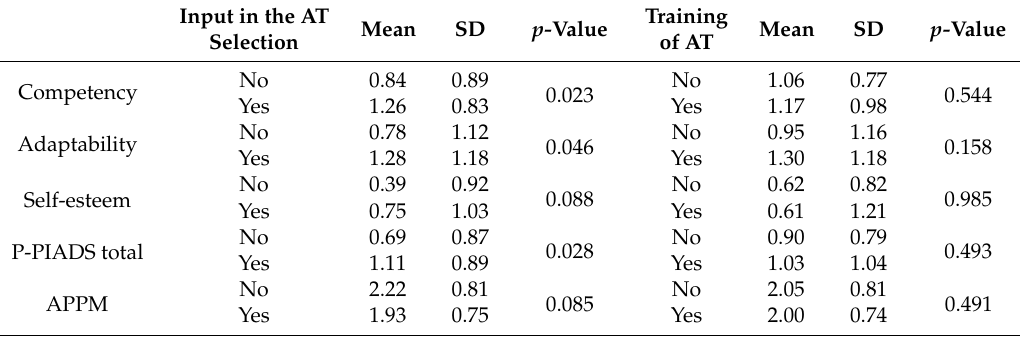
Table 3. Psychosocial impact of AT and participation profile among who gave/did not give input in the AT selection and among who received/did not receive AT training after